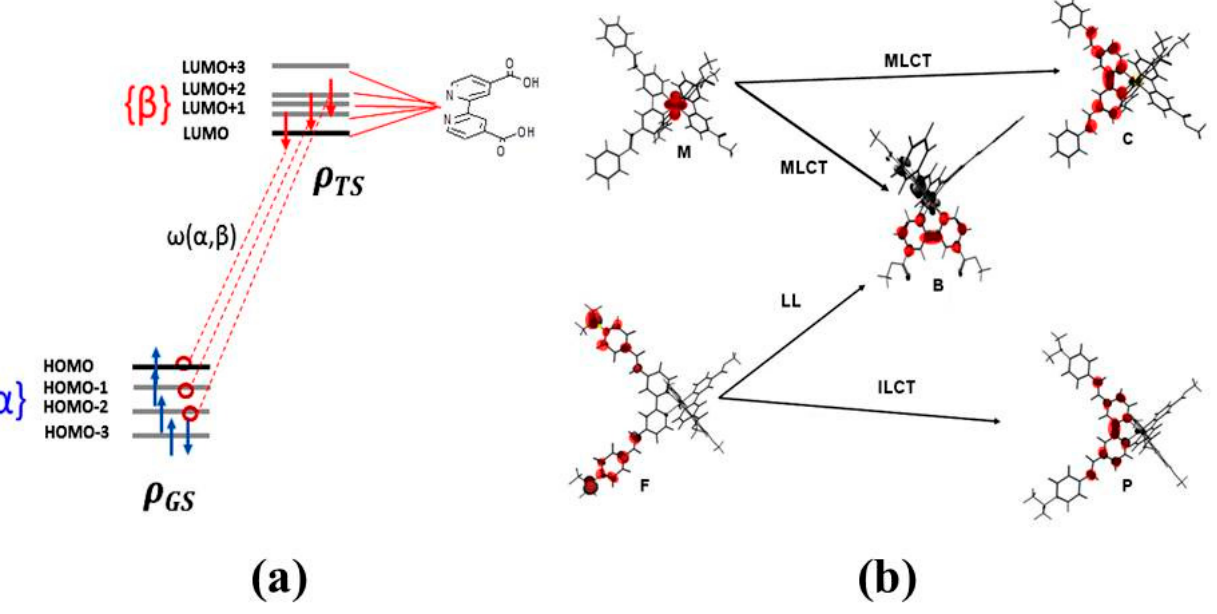
Figure 9. ( a ) ground state density ρ GS , transition density ρ TS , ω ( α , β ) distribution function, { α β } molecular orbitals. ( b ) Possible electronic transitions: MB: MLCT band to the bpy carboxylate ligand; MC: MLCT band to the chromophoric ligand; LL transition; ILCT: intraligand charge transfer.